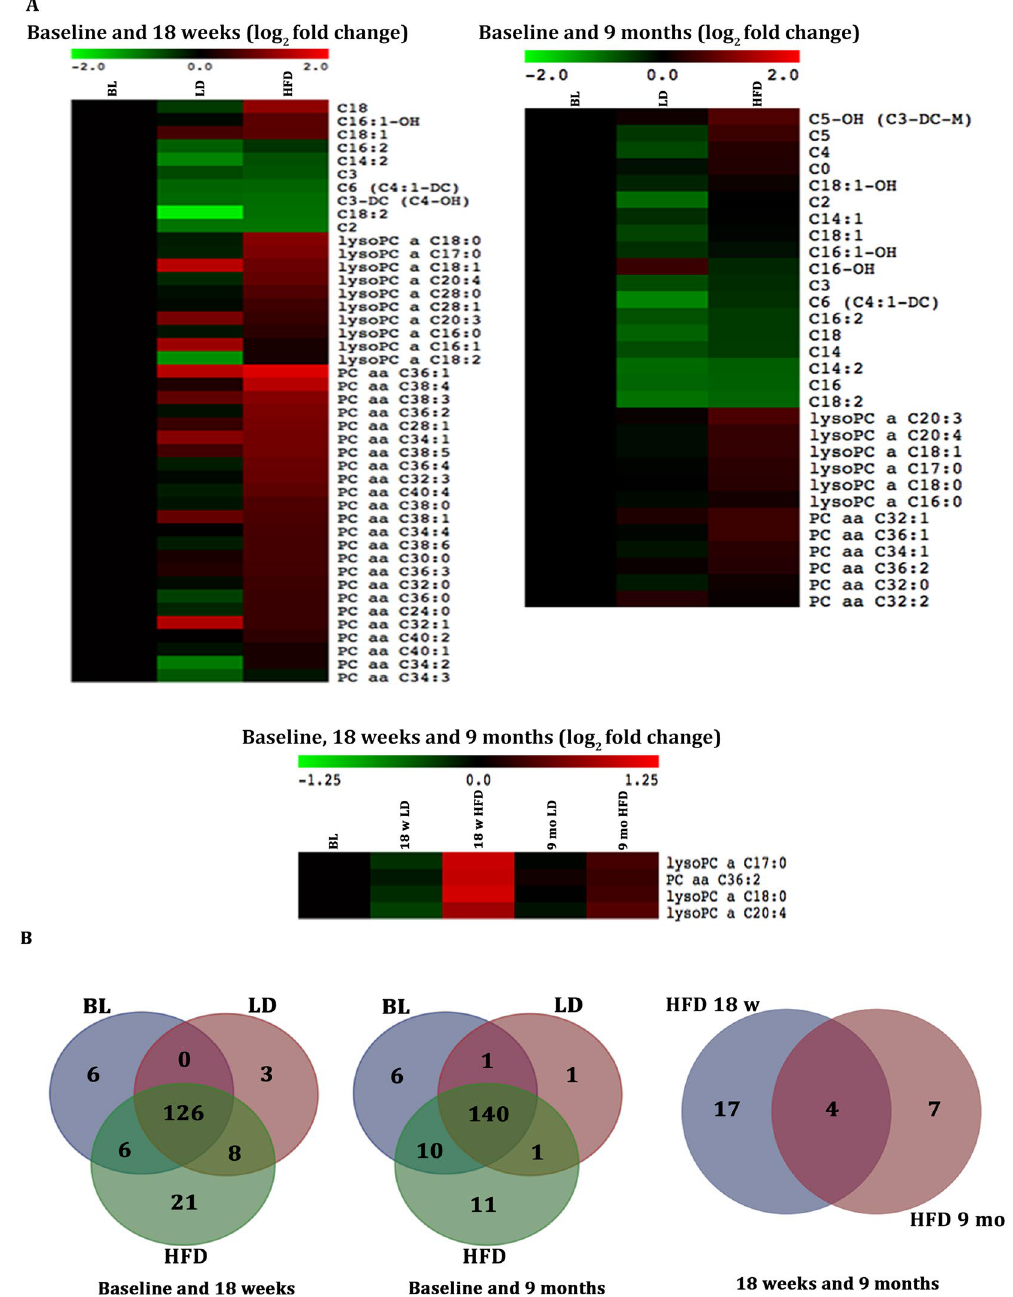
Figure 4. High fat diet-fed mice exhibit distinct and sustained longitudinal changes in selected metabolites. Metabolites shown were selected based on VIP scores ≥ 1 and One-way ANOVA (p < 0.05). ( A ) Heat maps showing the median-normalized fold change in the metabolites levels of mice at baseline, and 18 weeks of high fat diet (HFD) or lean diet (LD), or at baseline and 9 months of age from HFD- and LD- fed mice. ( B ) Venn diagrams representing metabolites identified and grouped based on One-Way ANOVA and Fisher's LSD post-hoc tests (p < 0.05 representing a significant difference between individual groups). Metabolites not meeting predetermined cut-offs are located centrally in the 18 week and 9 month venn diagrams (126 and 140 metabolites, respectively) (n = 10 per group per time